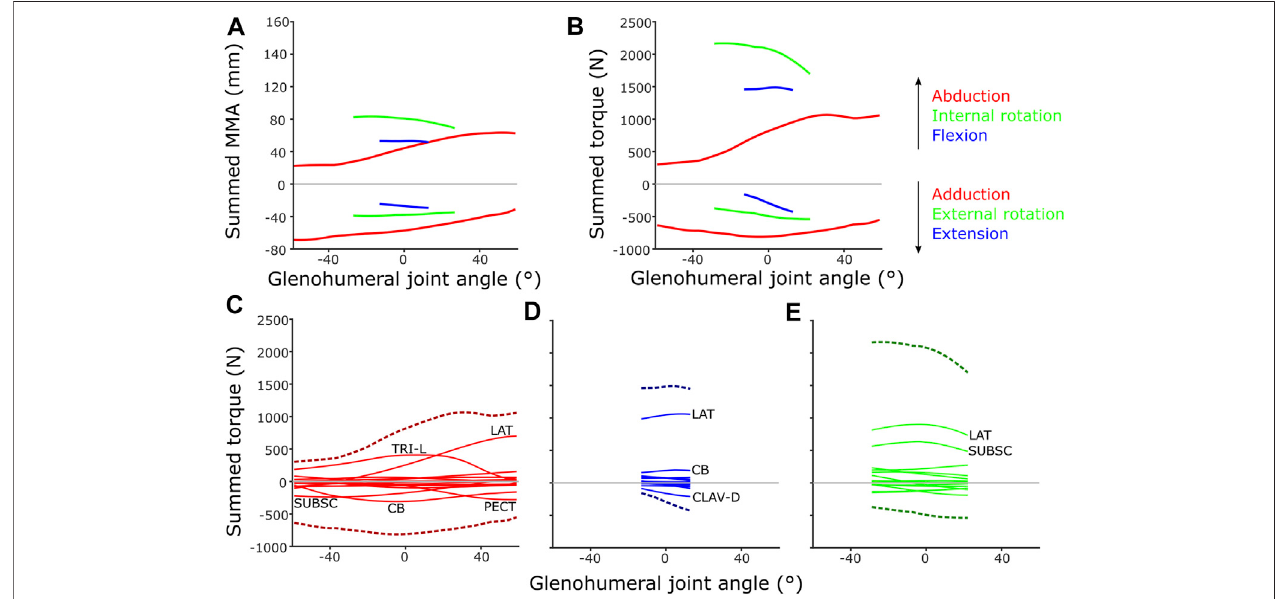
FIGURE12 | Model-predictedMMAs and muscletorquesat the glenohumeral joint,using theupdatedSIMM model muscle pathways from diceCT and forsingle- axis DOF rotations: (A) Summed MMAs, (B) Summed torques. Major muscles contributing to summed torque (dashed lines) are labelled for each rotational DOF: (C) Abduction-adduction, (D) Flexion-extension, (E) Internal-externalrotation.LAT (cid:3) m.latissimusdorsi,TRI-L (cid:3) m.tricepsbrachiilongus,SUBSC (cid:3) m.subscapularis,CB (cid:3) m. coracobrachialis, CLAV-D (cid:3) m. clavodeltoideus. For details on individual muscles, see the Supplementary Material